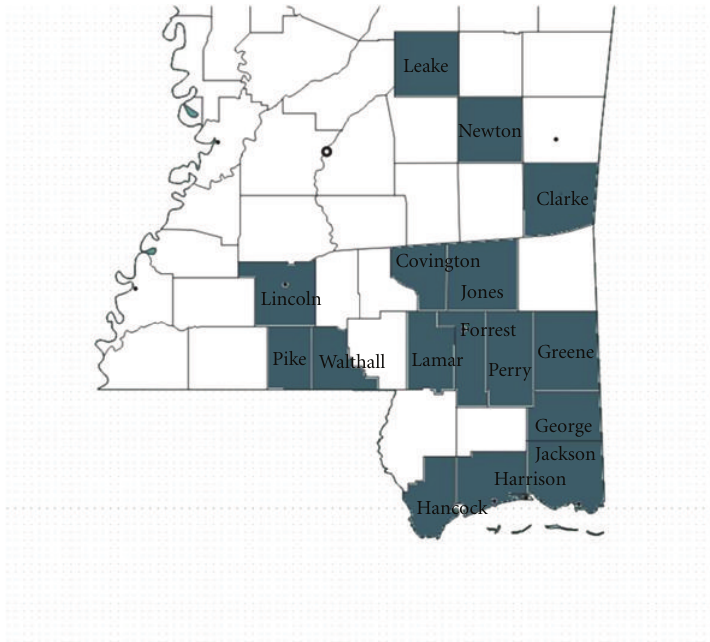
Figure 1: Mississippi County map. Counties that had their debris removal missions managed by the USACE are shaded and have name